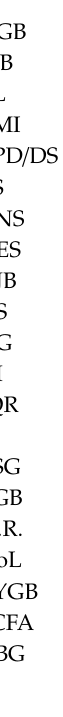
Table S3: Group 3—Bariatric surgery and probiotics, Table S4: Subgroup microbiota changes results, Table S5: OHAT Risk of